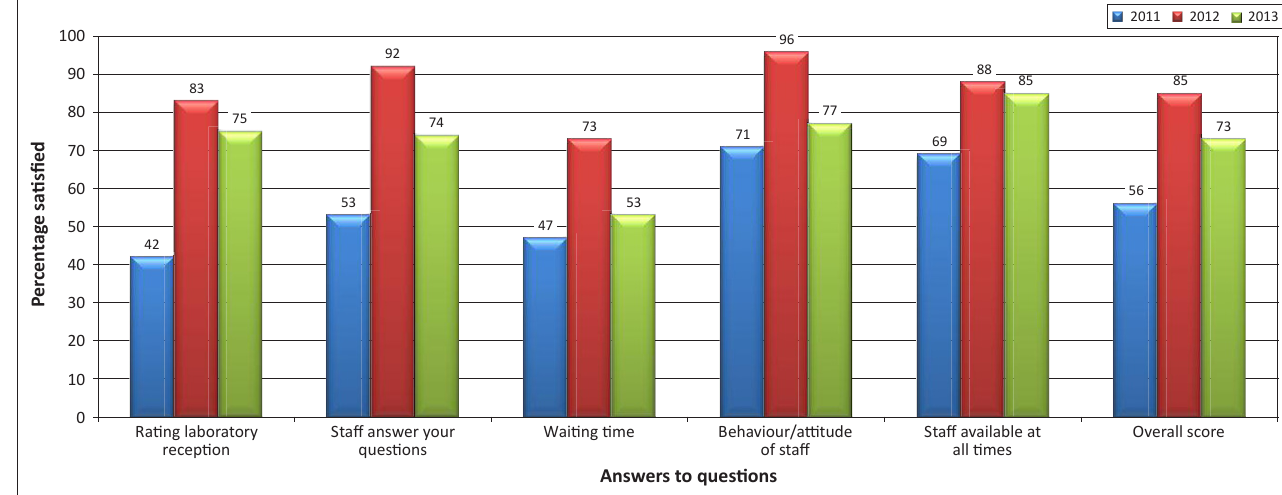
FIGURE 2a: Percentage of patients who reported satisfaction with selected services (2011 to 2013).